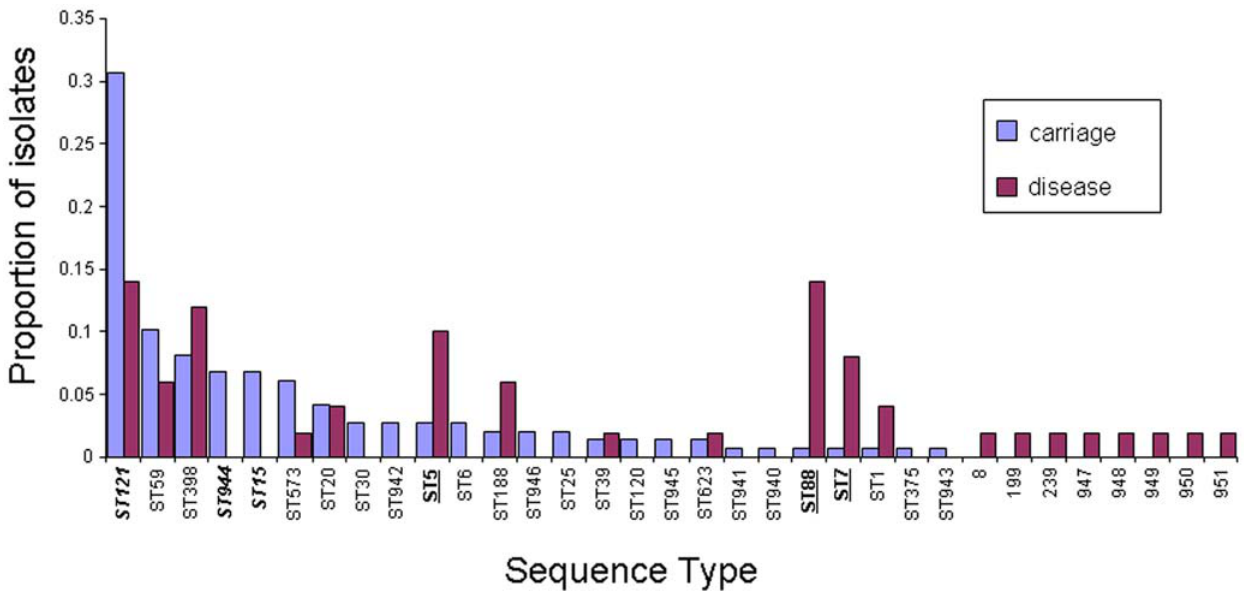
Figure 5. The proportions of each ST noted in the disease and pooled carriage sample. A resampling procedure showed that STs 121, 944 and 15 were significantly under-represented from cases of disease (bold, italics), whilst STs 5, 88 and 7 were significantly over-represented from cases of disease (bold, underlined).